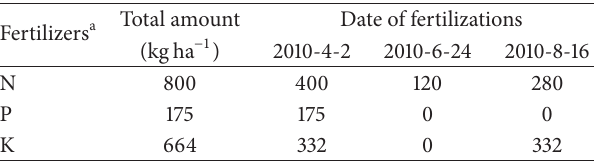
Table 1: Details of fertilization events in the apple orchard.